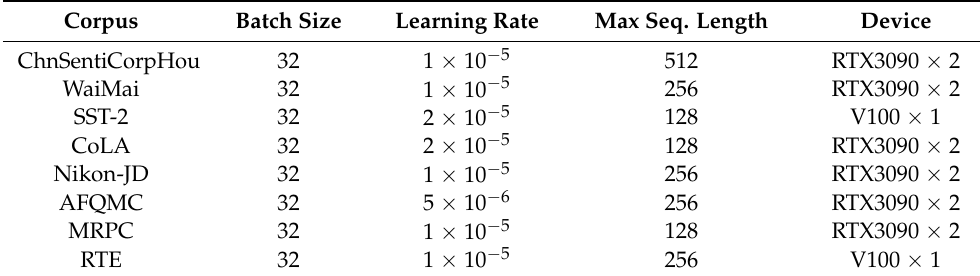
Table 4. Parameter settings in our